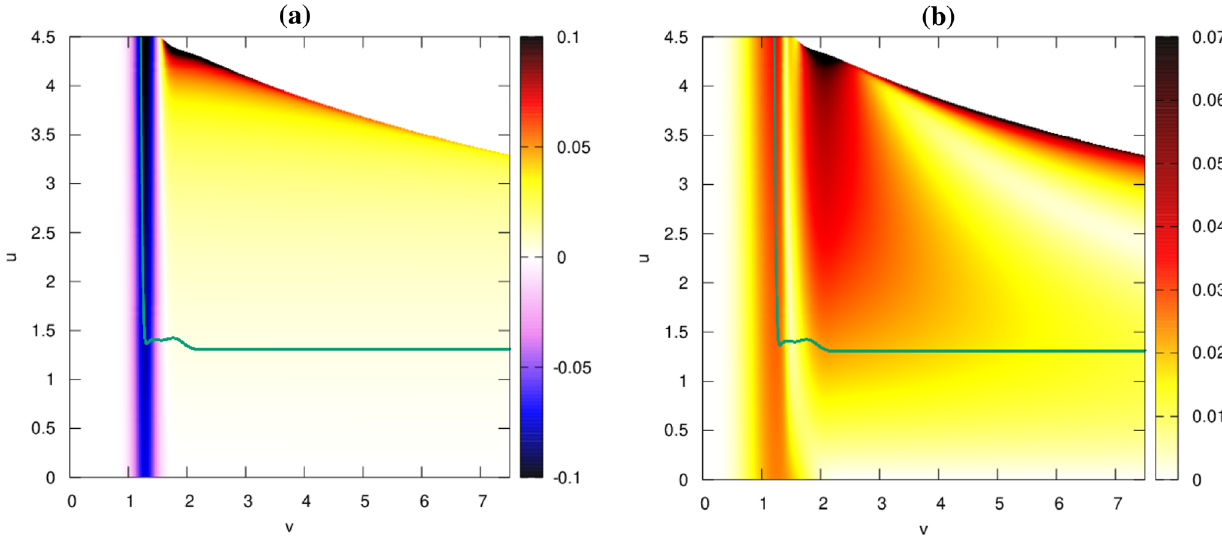
Fig. 16 The ( v u ) -distribution of a the neutral scalar field, h , and b the moduli of the complex scalar field, | X | , for the same parameters and field amplitudes as in Fig.